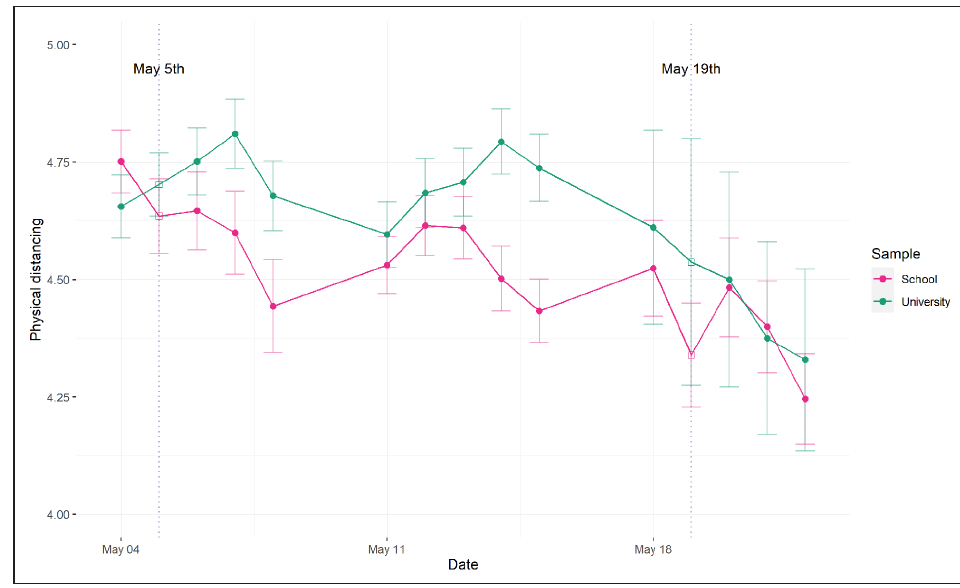
Figure 2 Average Physical Distancing Behavior in the Two Samples from Monday May 4th until Friday May 22nd. Note : Days on which a press conference was held are marked with a box and a vertical line (May 5th and May 19th).